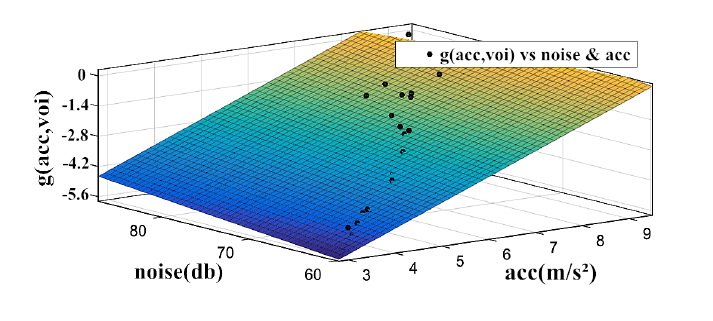
Figure 3. Curve fitting for the parameters in g ( acc , voi ) .